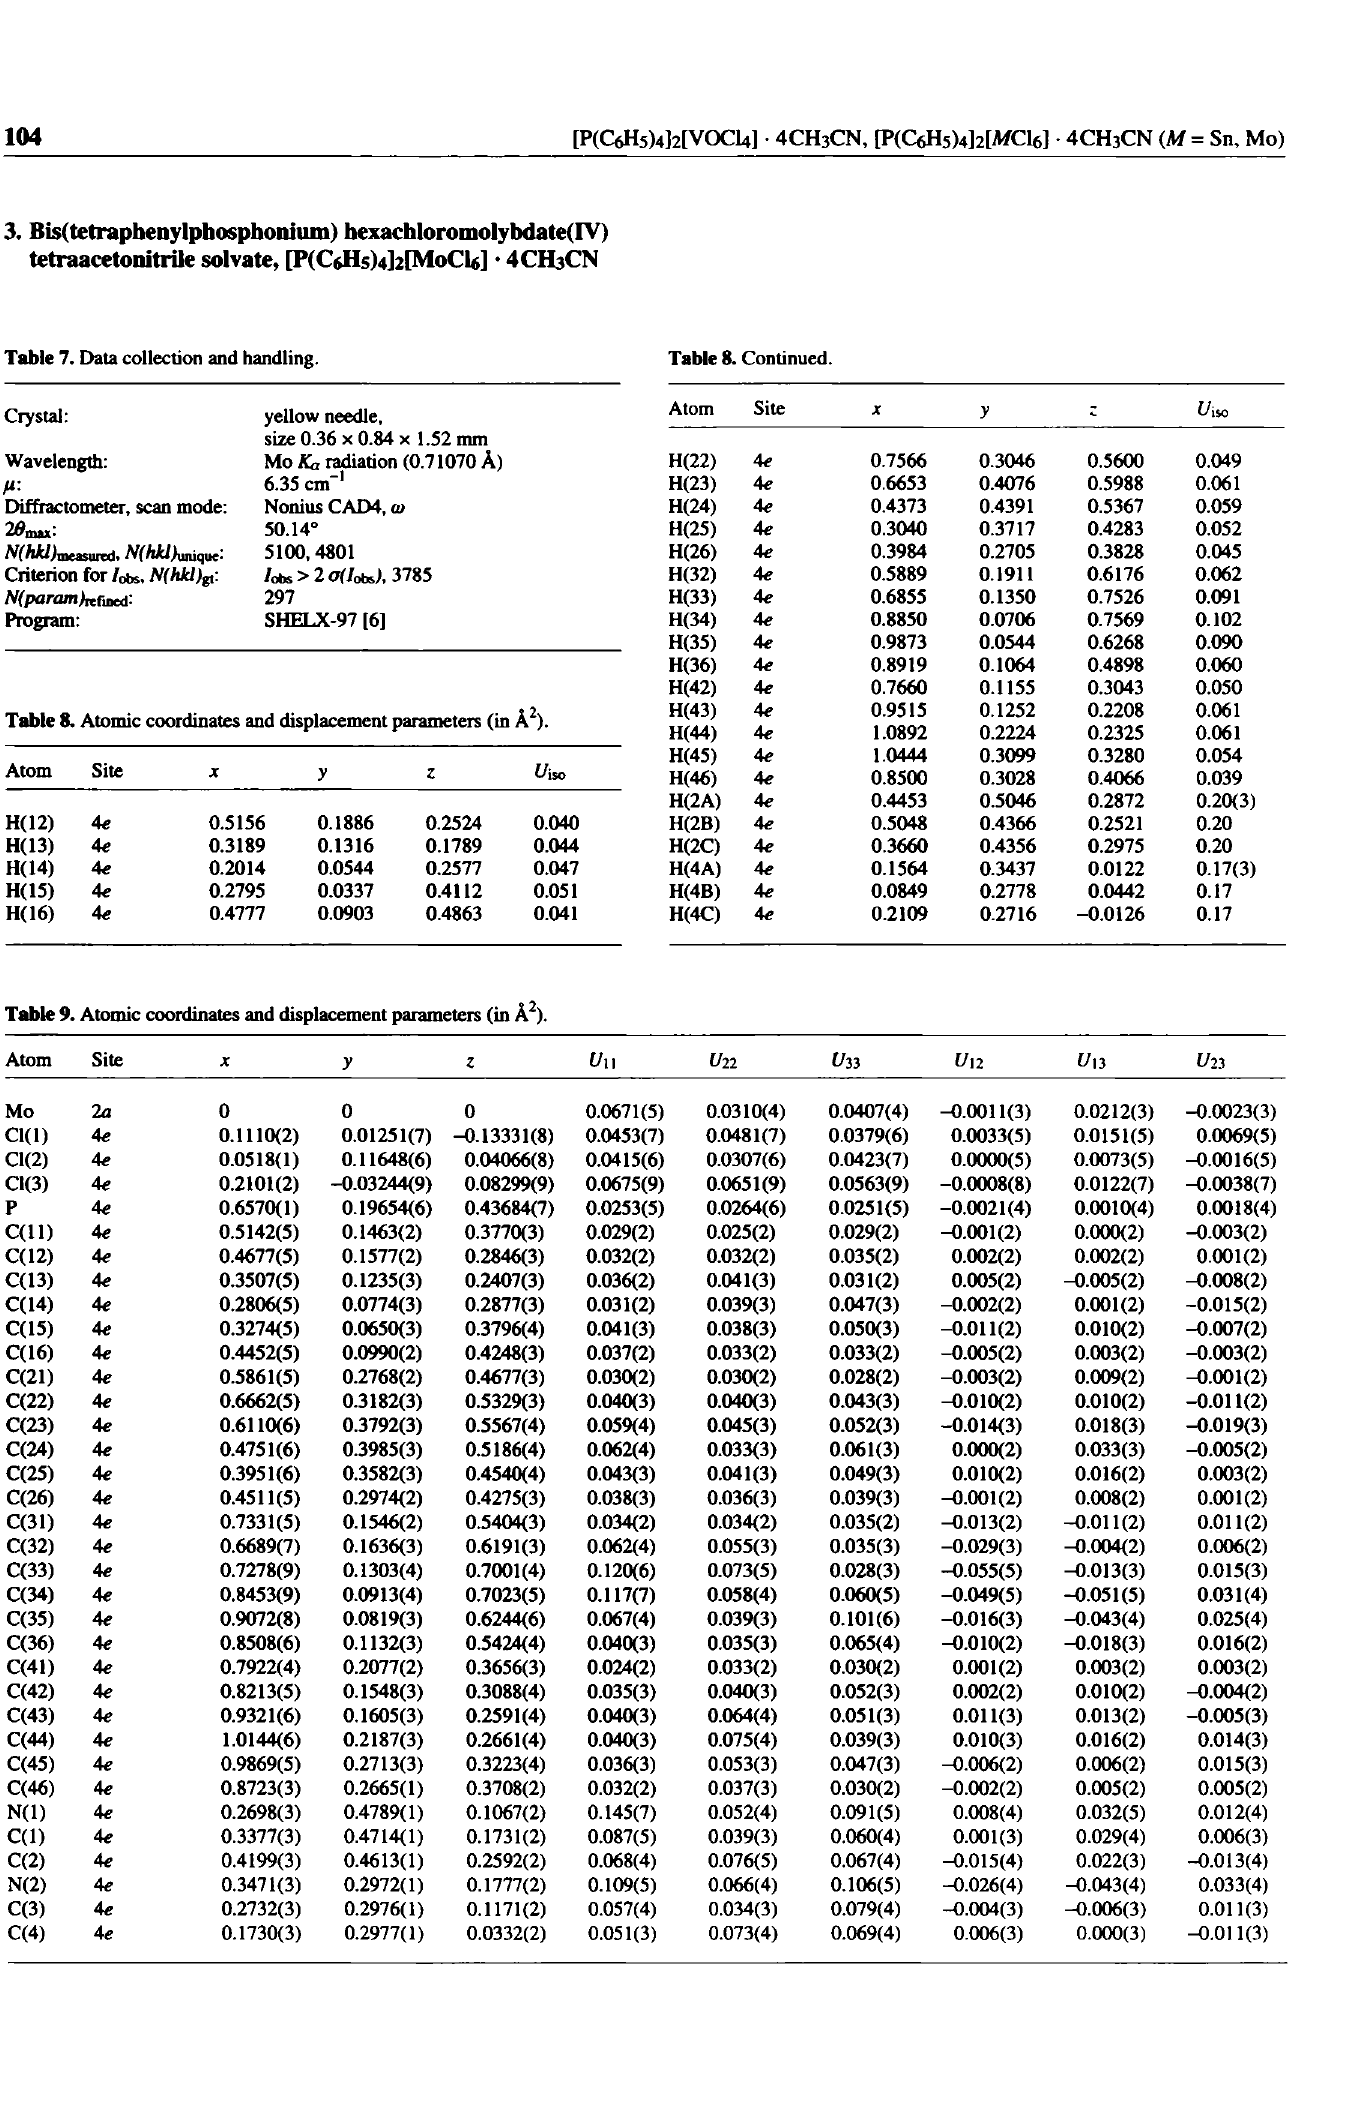
Table 9. Atomic coordinates and displacement parameters (in Â 2